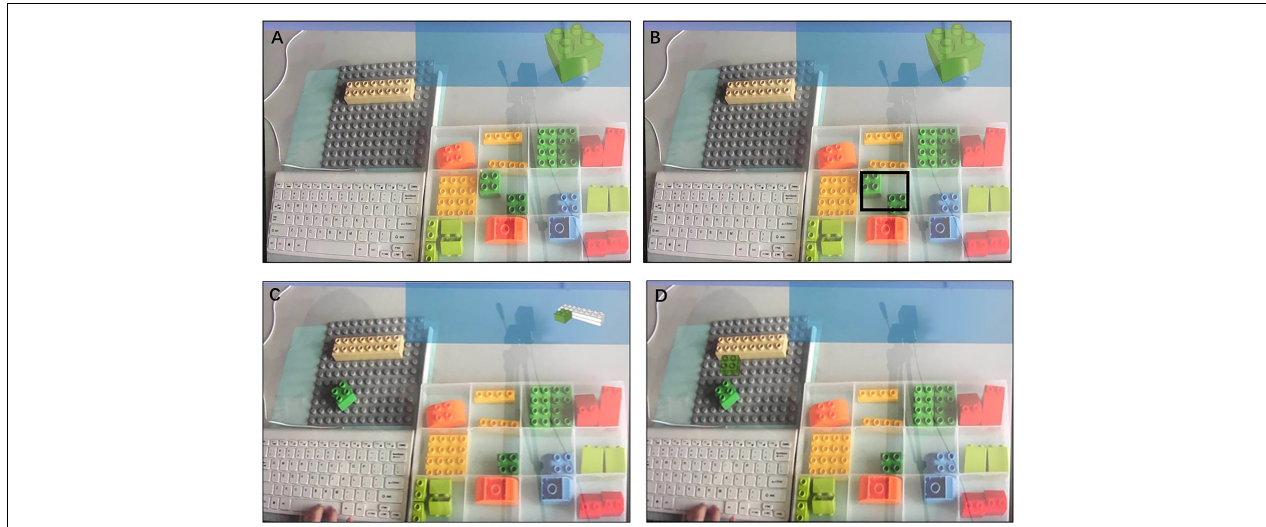
FIGURE 5 | (A) Display of screen-based documentation-assisted group in commissioning subtask, (B) Display of AR-assisted group in commissioning subtask, (C) Display of screen-based documentation-assisted- assisted group in joining subtask, and (D) Display of AR-assisted group in joining